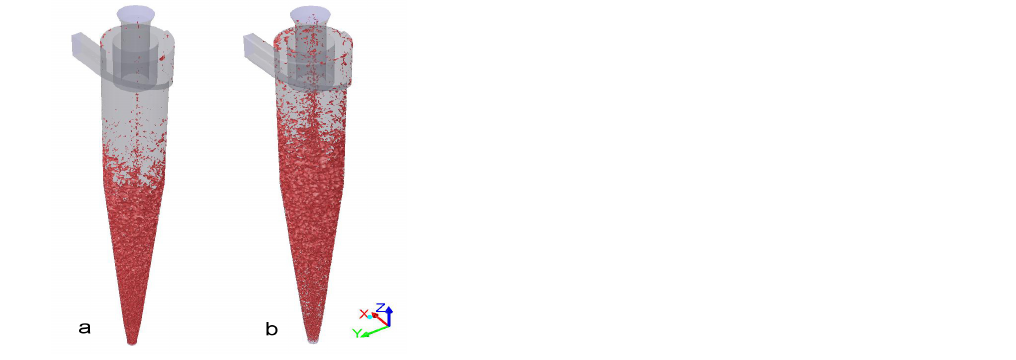
Figure 9. Iso-Surface of particle concentration above 600 kg/m 3 from the VOF-DEM models at flow-time 4 s: ( a ) RSM and ( b ) LES.